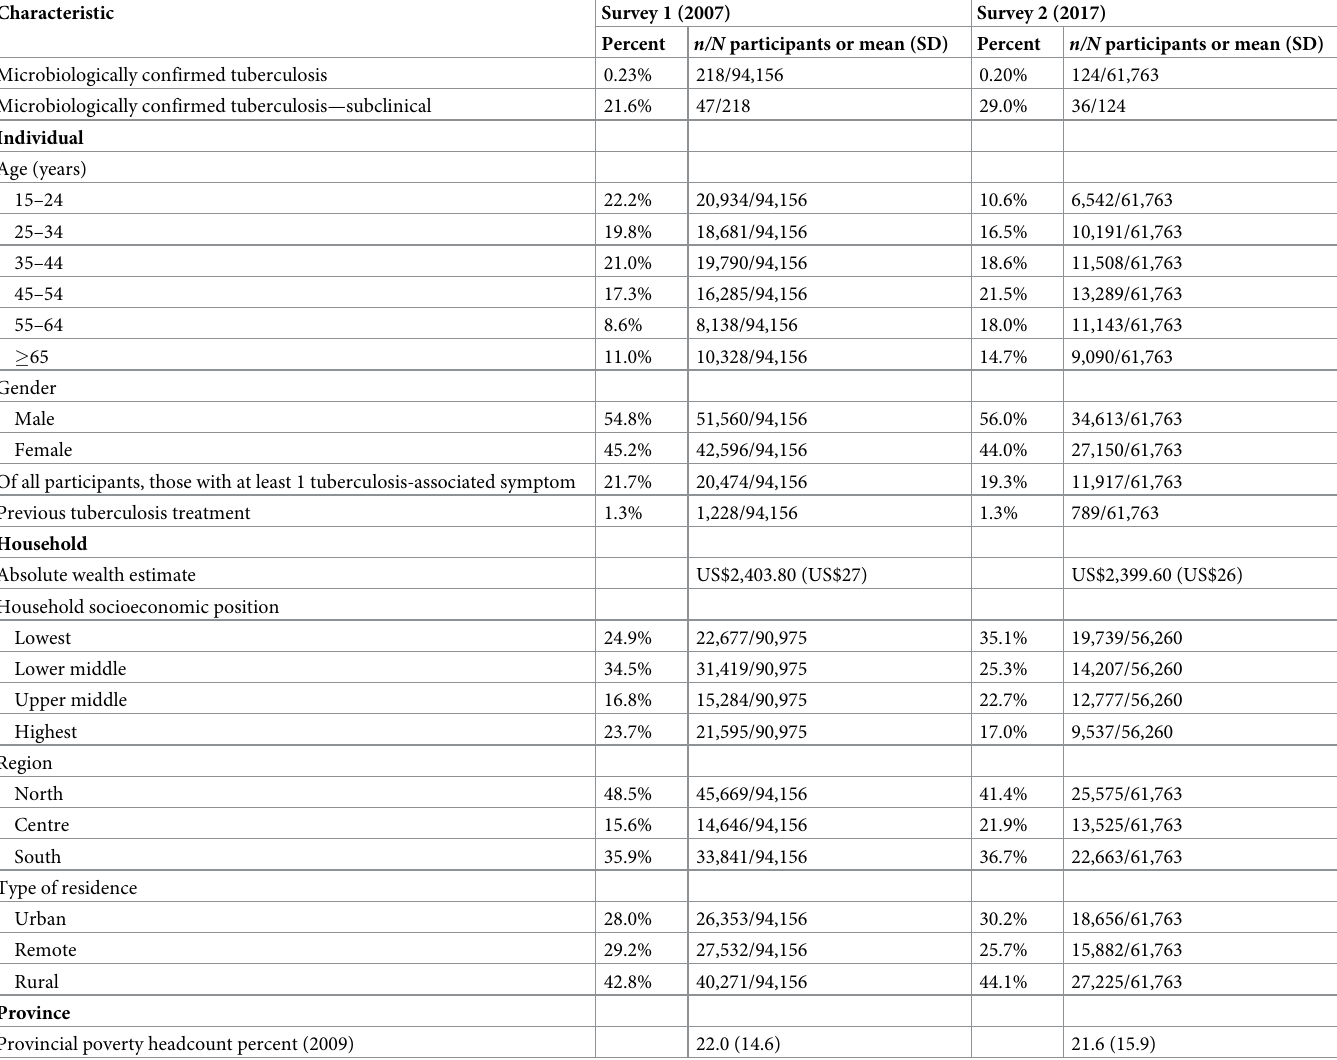
Table 1. Comparison of the characteristics of study participants between survey 1 and survey